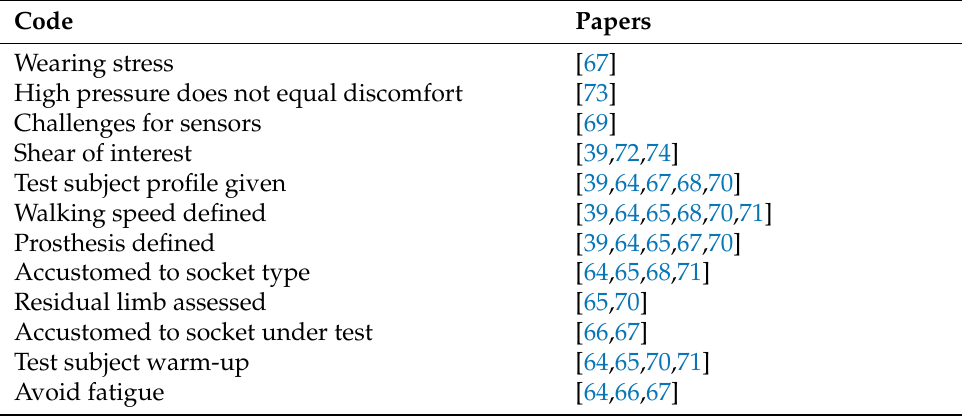
Table 6. References to domain